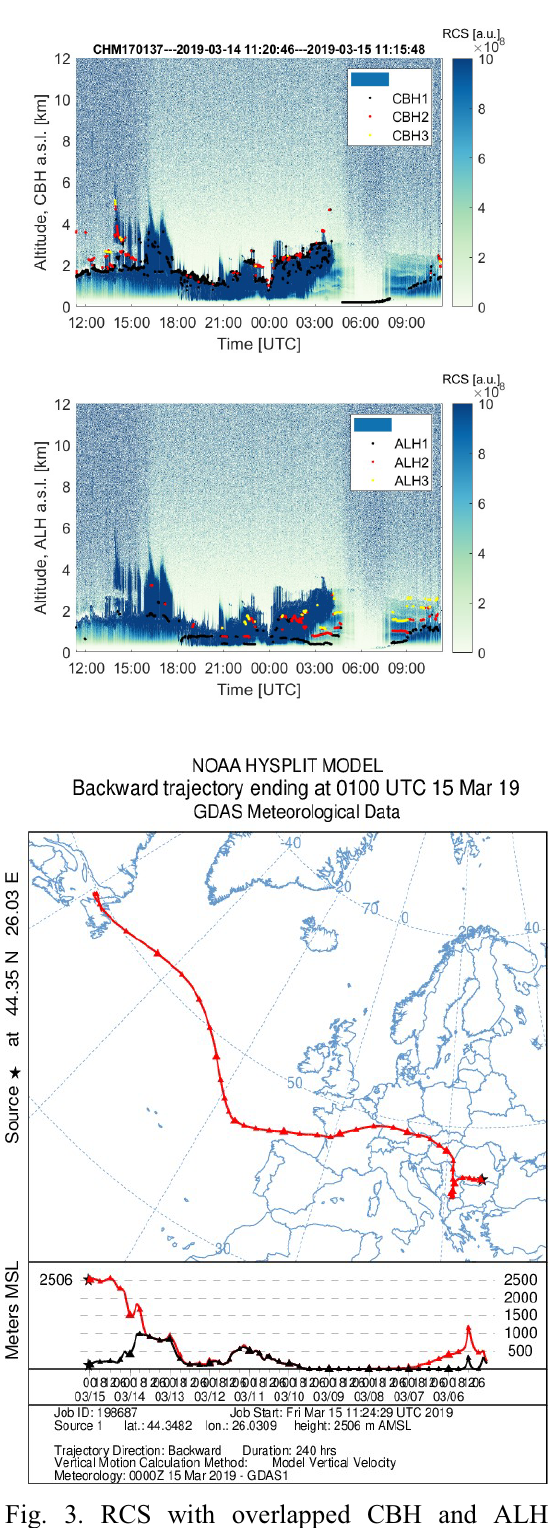
Fig. 3. RCS with overlapped CBH and ALH (upper) and Hysplit backtrajectory (lower).